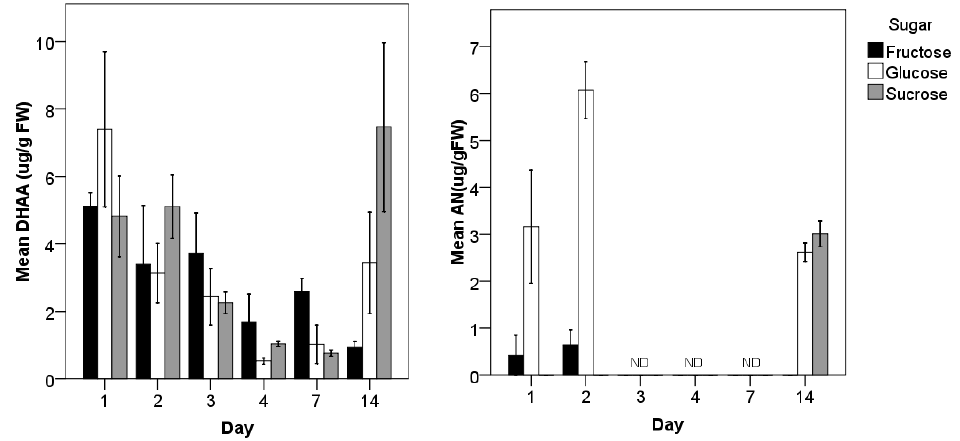
Figure 5. AN and DHAA levels in A. annua seedlings grown 14 days in glucose, fructose, or sucrose. Bars are